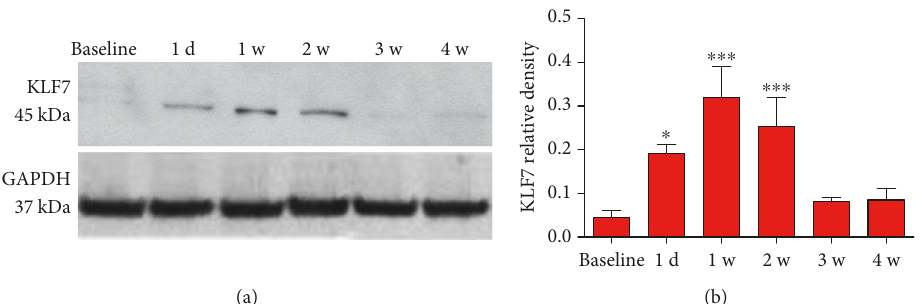
Figure 5: KLF7 expression is dynamically altered following SCI. (a) Western blot analysis revealed the endogenous change in KLF7 expression in the thoracic spinal cord injury tissue after SCI. (b) Graphs represent the KLF7 relative density of the bands normalized to GAPDH across di ff erent time points. n = 6 , error bars denote SD. ∗ P < 0 05 , ∗∗∗ P < 0 001 versus the baseline. One-way ANOVA, Tukey ’ s post hoc test.